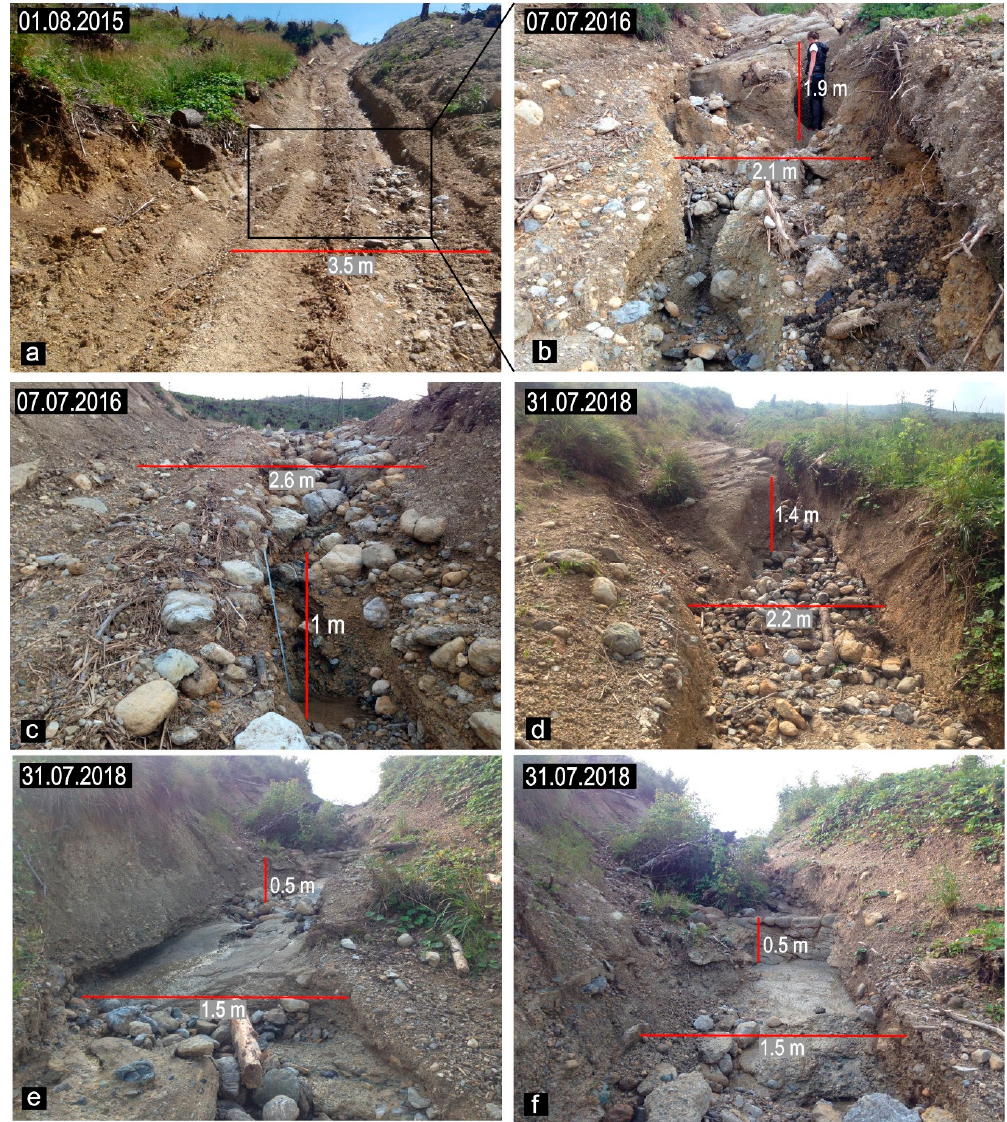
Figure 2. Changes on the surface of the studied road, explanations: the road in use in the first year after its construction ( a ); deep incisions formed after heavy rainfall, which contributed to exclusion the road from usage ( b , c ); strong relief transformations on the road two years after exclusion the road from usage ( d – f ). Table 1. Annual and summer season sum of precipitation between 2017 and 2019 (Data source: the Institute of Meteorology and Water Management - National Research Institute).